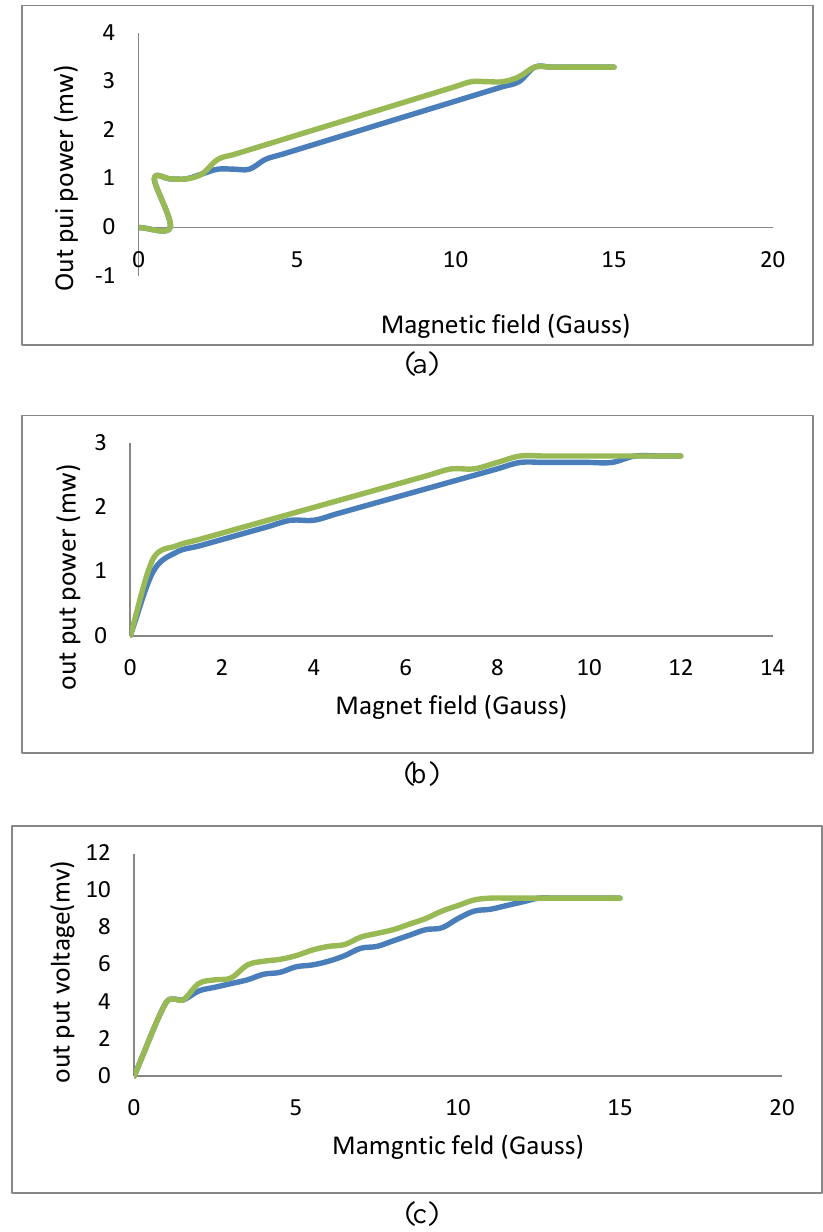
Fig.4: The hysteresis loop of ferrofluid that is doped with copper nanoparticles using violet semiconductor, green and He-Ne